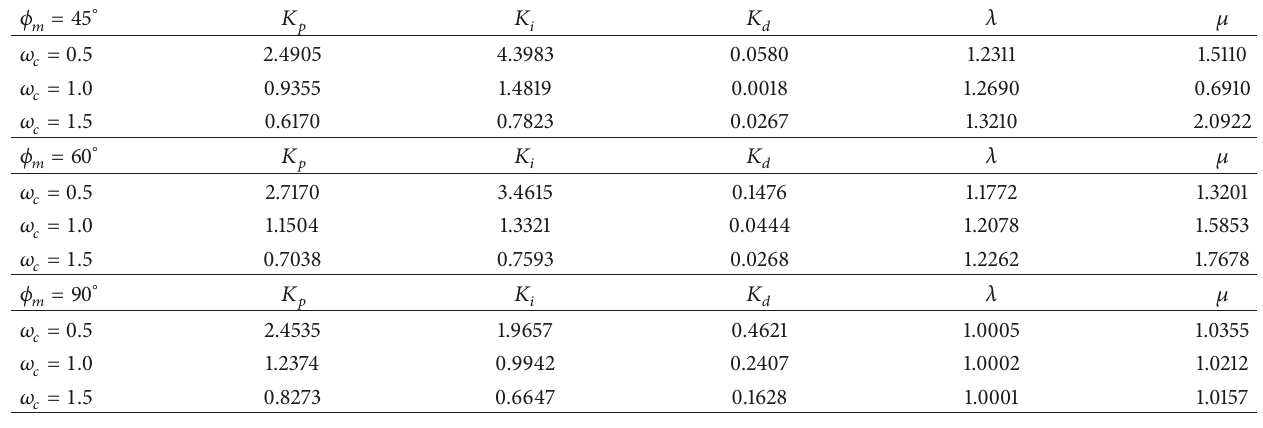
Table 3: Controller parameters of 𝑃 3 (𝑠) .